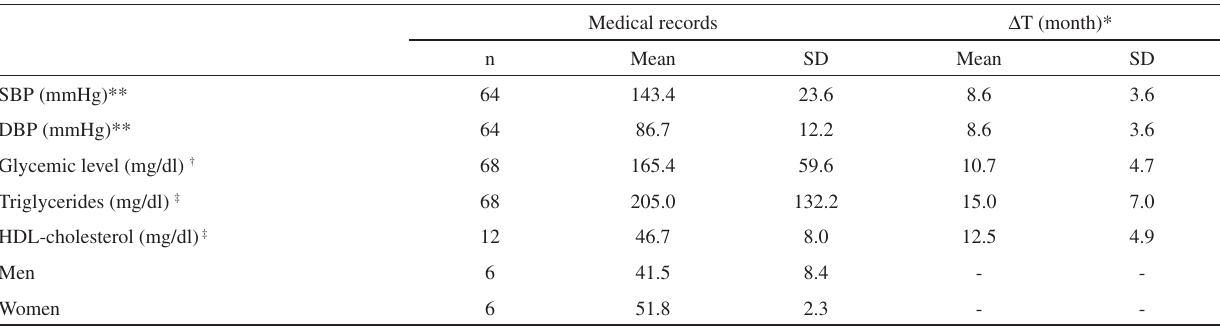
Table 4 - Mean and standard deviation of clinical and laboratory tests of patients included in this study. Period of time be- tween last medical records and at the time of patient inclusion in the study